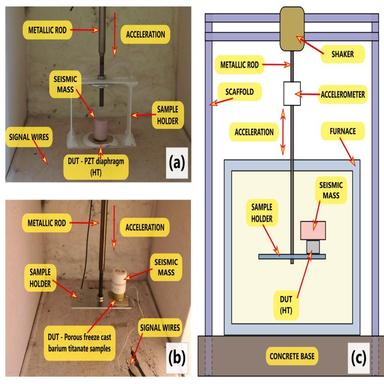
Example of sample montage for high temperature testing of piezoelectric transducer; (a) image from testing of a PZT diaphragm; (b) image of testing of a porous barium titanate sample; (c) schematic diagram of sample montage and placement in the furnace chamber. (https://doi.org/10.6084/m9.figshare.12585023) (https://doi.org/10.6084/m9.figshare.12585023), CC BY 4.0 license].